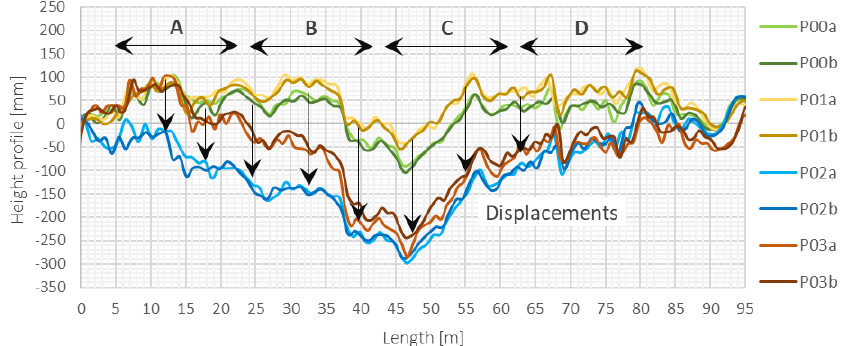
Figure 19. Height profiles estimated using the measurements of two pressure transducers ( a, b ) within hydraulic sensor during subsequent measurement sessions ( P00–P04 ).